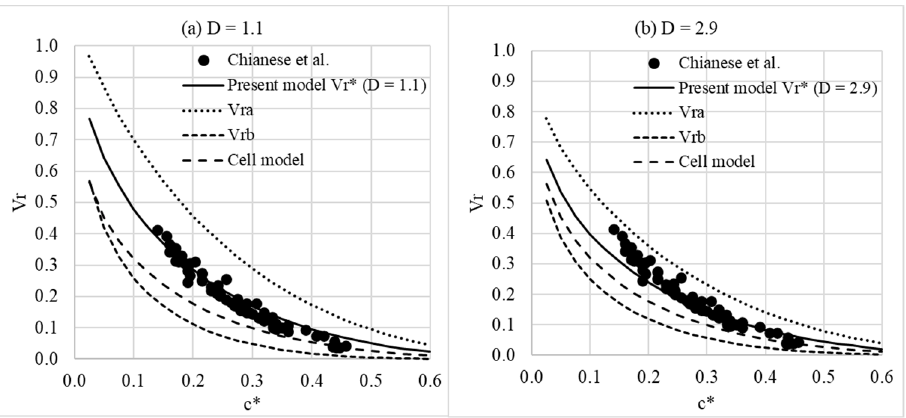
Figure 2. Comparison with experimental data from Chianese et al. [10] for the fluidization of irregular shape particles with ( a ) D = 1.1 and ( b ) D = 2.9. In ( a ) and ( b ), Vra = Vr* + s and Vrb = Vr* - s.